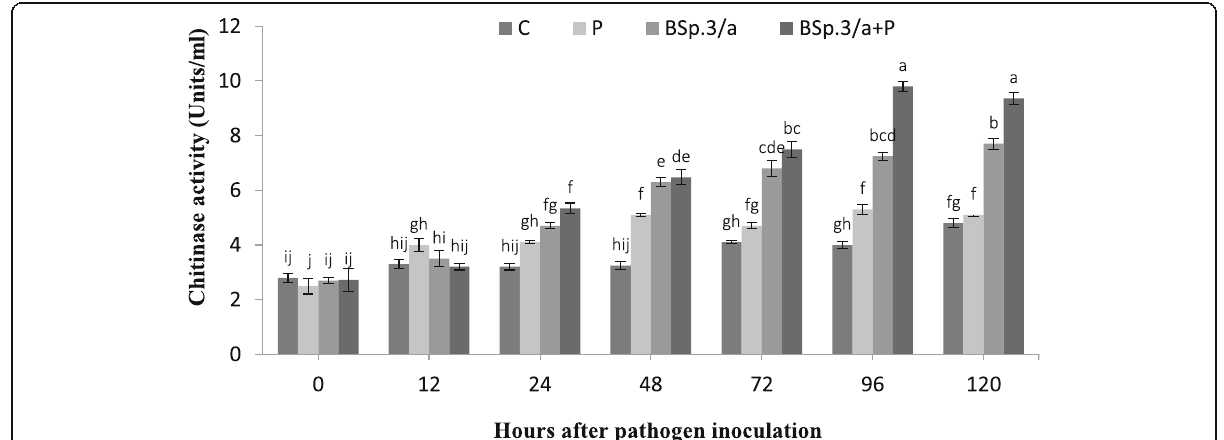
Fig. 6 Influence of PGPR strain BSp.3/aM treatment on chitinase